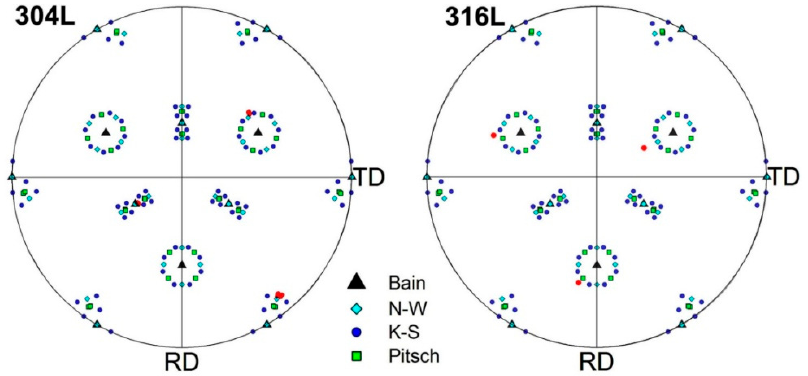
Figure 6. Representative examples of {0 0 1} pole figures of martensite (red points) in 304L and 316L stainless steels, that were obtained from the selected portions in Figure 5a,b, respectively, along with predicted orientations of martensite.